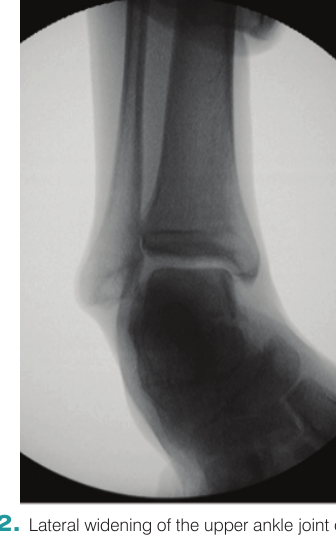
Figure 2. Lateral widening of the upper ankle joint on stress view